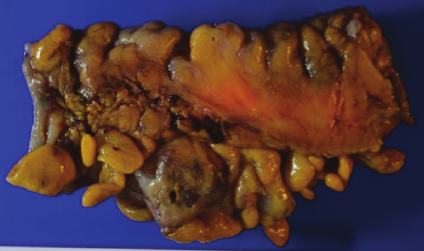
Figure 6: Resected specimen of the sigmoid colon. Multiple stool- filled diverticula were found, one of which had a perforation, through which stool was visible.